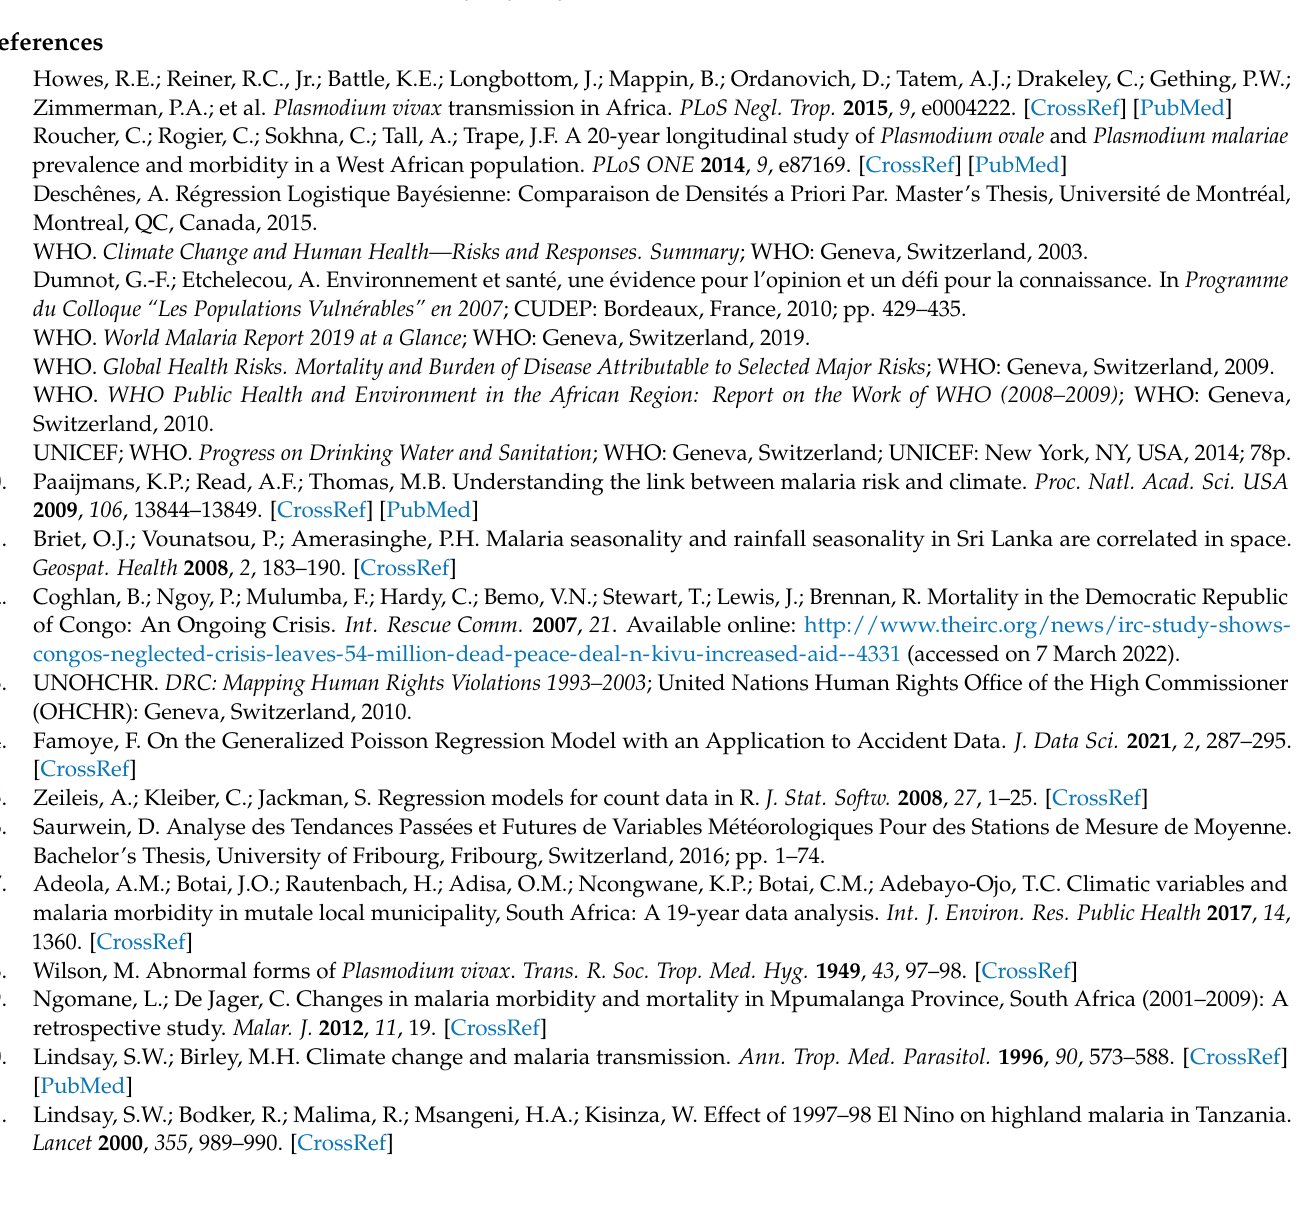
Figure A6. Rainy day (days) in DRC (2001–2019).